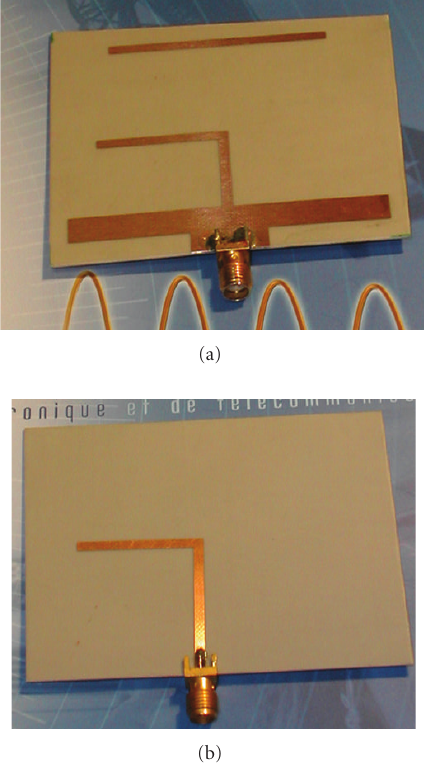
Figure 5: Photo of the printed dipole antenna with reflector and director.